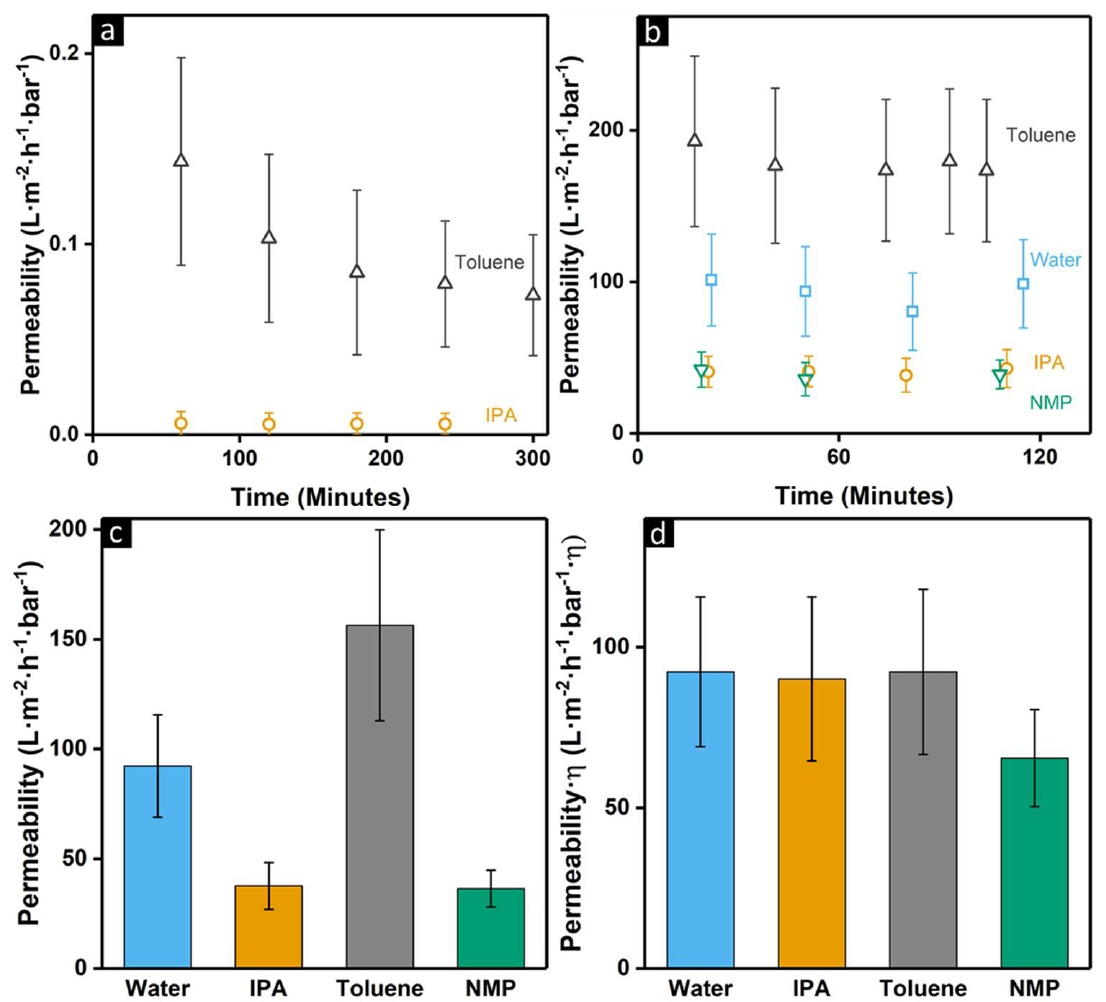
Figure 2. ( a ) Permeability of toluene and IPA (20 bar of applied pressure), through NF membranes prepared with a 20% w / v PSaMA with 40% v / v acetic acid polymer casting solution prepared in a 2.5 M H 3 PO 4 coagulation bath and crosslinked with PEI. ( b ) Permeability of various solvents through UF membranes at 1 bar of applied pressure, prepared with a 20% w / v PSaMA with 40% v / v acetic acid polymer casting solution prepared in a 0.1 M HCl coagulation bath and crosslinked with PEI. ( c ) The average permeability of various solvents through UF membranes at 1 bar of applied pressure. ( d ) The average permeability of the solvents though the UF membranes at 1 bar of applied pressure multiplied by the viscosity ( η ) of the solvent. The error bars indicate the standard deviation of at least 3 different membrane